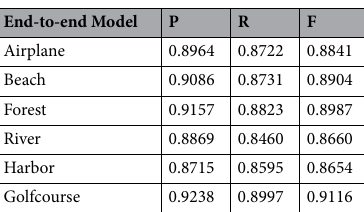
Table 6. Experimental results from UC Merced Land-Use Data